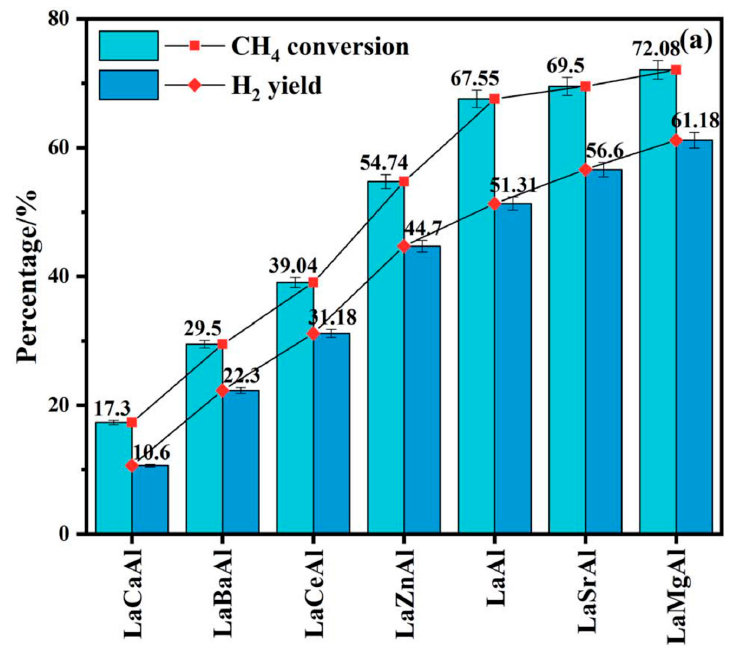
Figure 26. CH 4 conversion and H 2 yield for several A-site-substituted LaAlO 3 -supported Ni catalysts (Reprinted with permission from [104]). (Reprinted with permission from